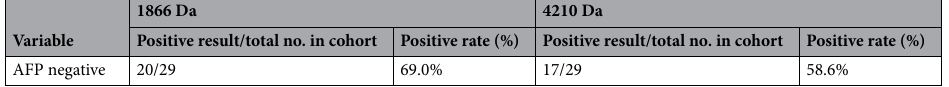
Table 4. Rates of 1866 Da and 4210 Da in AFP-negative patients with HCC (HCC vs. LC). AFP negative < 7.00 ng/ml; Positive result for 1866 Da 124.00 ≥ 80.00 mV; Positive result for 4210 Da < 152.00 mV.